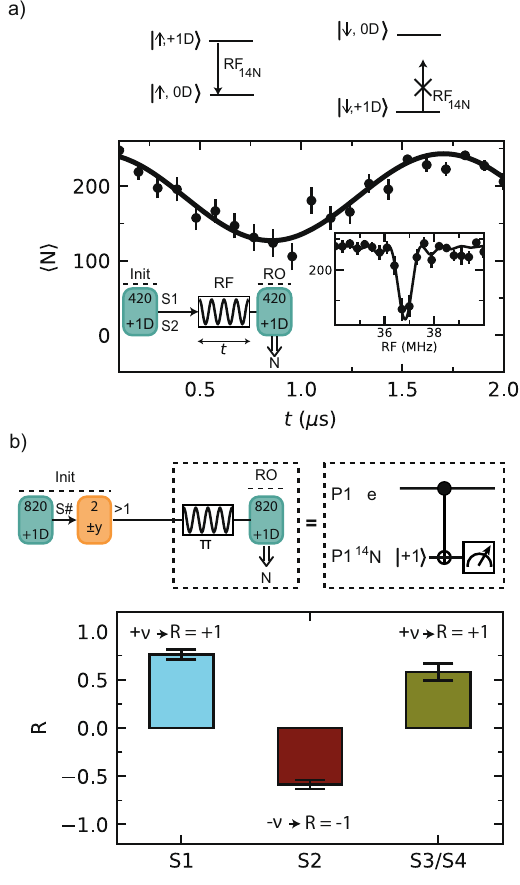
Fig. 4 Nitrogen nuclear spin control and NV – P1 coupling sign. a 14 N Rabi oscillation. Top: energy levels of the P1 electron spin in the {0D, + 1D} subspace. Bottom: either S1 or S2 is prepared in þ 1 ; D j i and the length t of a pulse at frequency RF = RF 14N = 36.8 MHz is varied. The nitrogen nuclear spin is driven conditionally on the electron spin state. Inset: NMR spectrum obtained by varying the frequency RF for a fi xed pulse duration t . b We use i , the electron the 14 N spin to determine the sign of the NV – P1 coupling. First, we prepare a selected P1 center ( K = 820) and initialize its electron spin ( L = 2). Second, we apply a π pulse at RF 14N , which implements an electron-controlled CNOT e,N (see level structure in a ). The coupling sign to the NV determines the P1 electron – spin state, and, in turn, the fi nal 14 N state. Finally, we measure the fi delity with the 14 N þ 1 j i state for two opposite electron spin initializations ( + y and − y fi nal π /2 pulse of DEER(y)). The normalized difference R of these measurements reveals the sign of the coupling (see “ Methods ” ). All error bars indicate one statistical standard